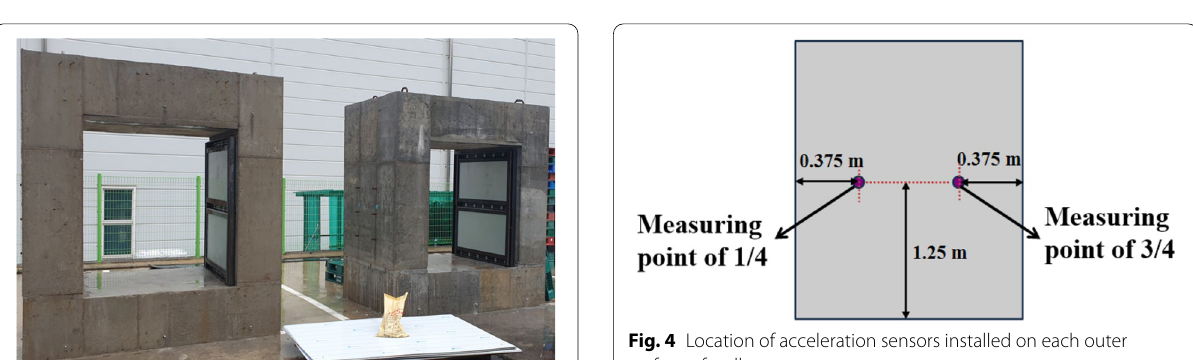
0.0374, 1 m 3.281 ft, 1 kgf 2.204 lbf. = = =